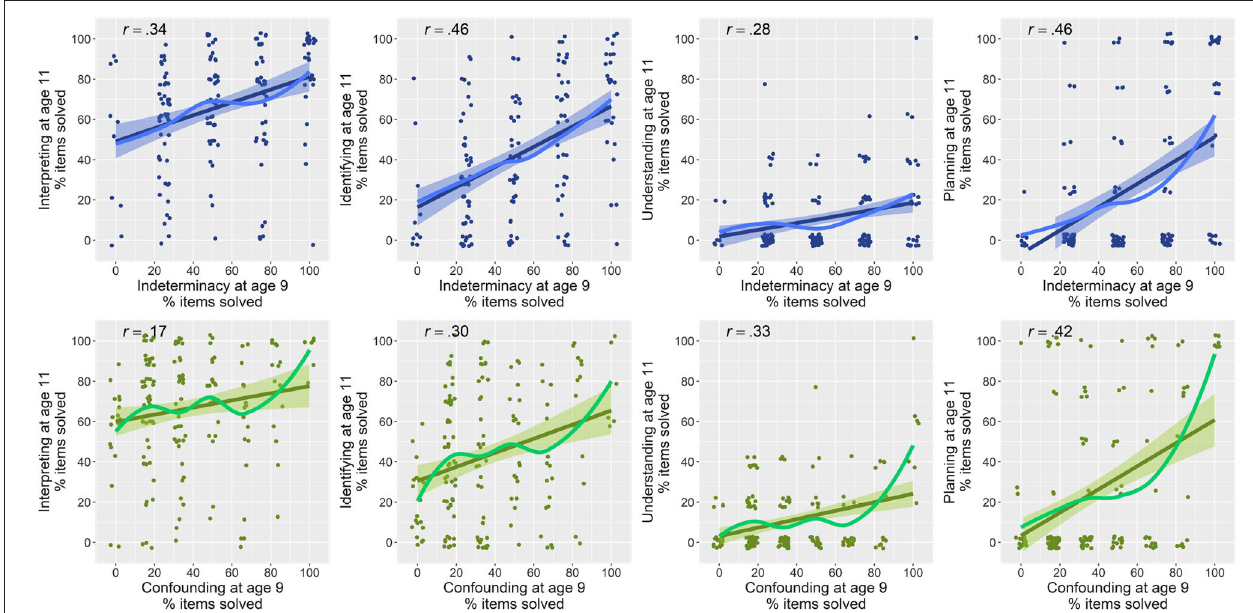
FIGURE 7 | Relations between children’s precursory skills and later CVS skills. First row shows relations of indeterminacy with later skills, and second row for confounding. Pearson correlations between variables are indicated in upper left of plots.